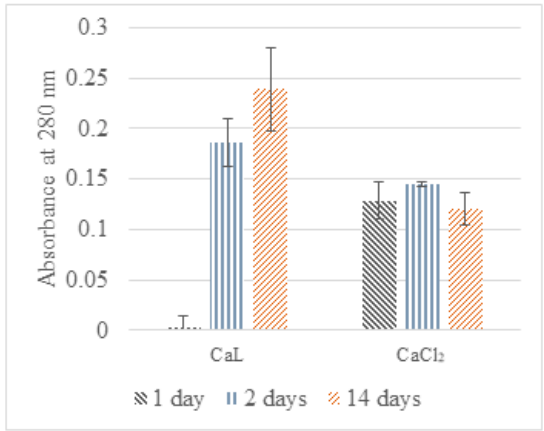
Figure 6. UV absorbance results (280 nm) of CF solutions with suspended N capsules from the CaL and the CaCl 2 series for 1, 2, and 14 days.